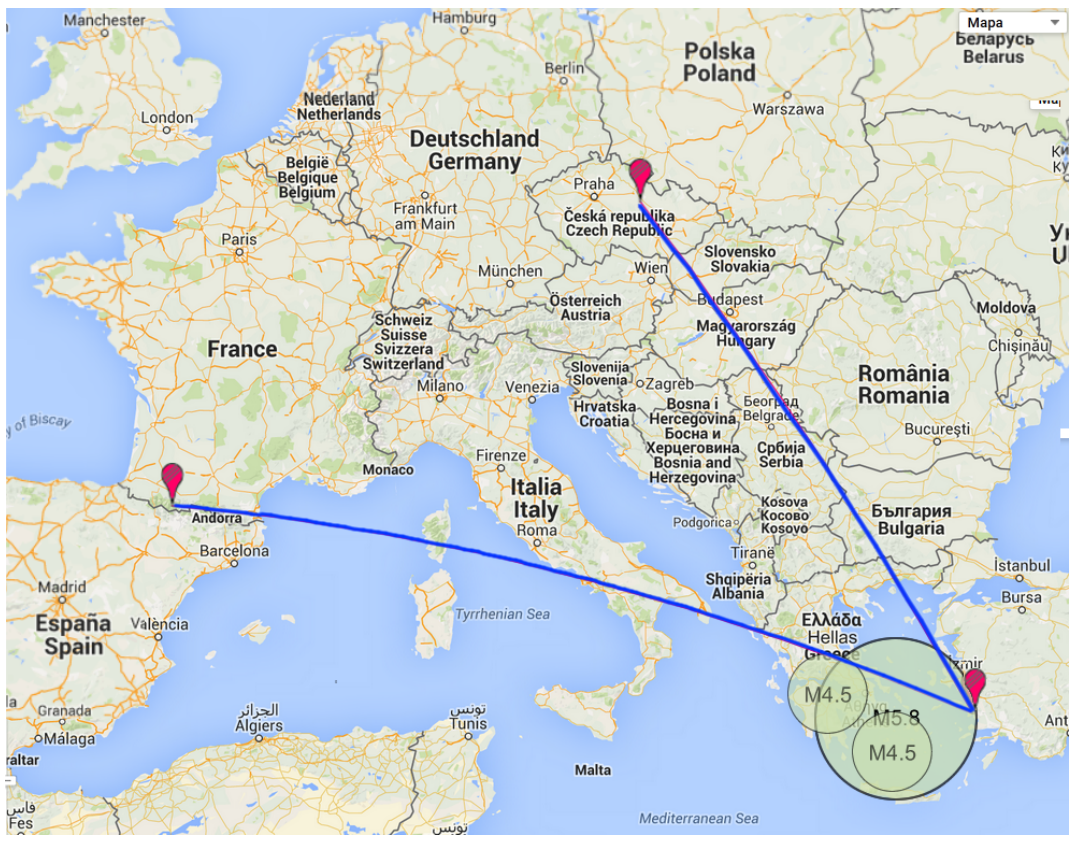
Figure 3. Great circle paths of VLF waves from TBB transmitter with the preparation zones for three